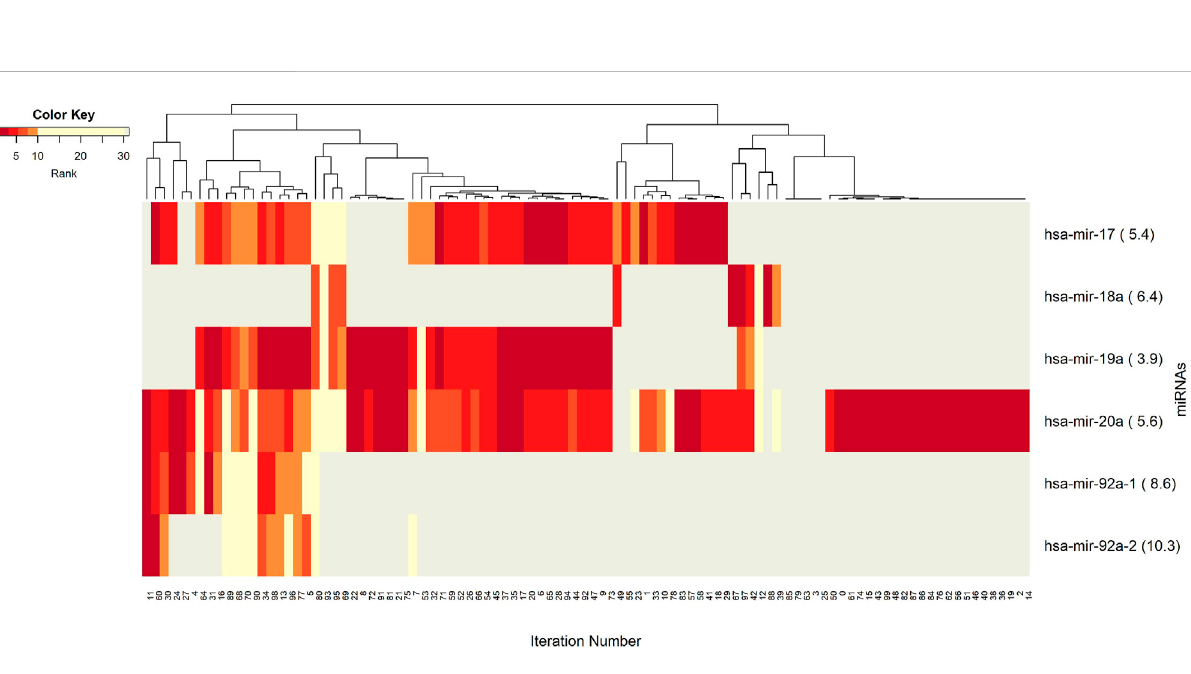
corresponding split. The numbers in parentheses following the feature name shows the average rank of the group over 100 splits. Figure 3 demonstrates the signi fi cant players (groups) with dark color, indicating that these groups are most frequently seen over